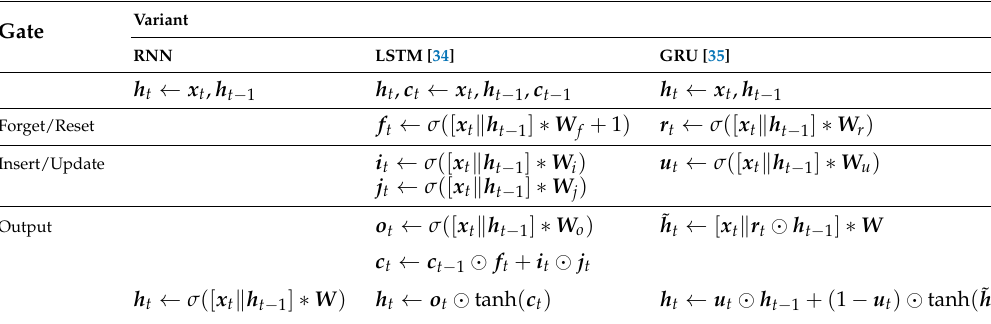
Figure 1. Schematic illustration of long short-term memory (LSTM) and gated recurrent unit (GRU) cells analogous to the cell definitions in Table 1. The cell output h t is calculated via internal gates and, based on the current input x t , combined with prior context information h t 1 , c t 1 . This is realized by a concatenation (concat.) of these tensors, as illustrated by merging arrows. LSTM cells are designed to separately accommodate long-term context in the internal cell state c t 1 , from short-term context h t 1 . GRU cells combine all context information in a single, but more sophisticated output h t 1 . Table 1. Update formulas of the convolutional variants of standard recurrent neural networks (RNNs), long short-term memory (LSTM) cells and gated recurrent units (GRUs). A convolution between matrices a and b is denoted by a b ; element-wise multiplication by the Hadamard operator a b ; ∗ (cid:12) and concatenation on the last dimension is marked by [ a b ] . The activation functions sigmoid σ ( x ) (cid:107) and tangens hyperbolicustanh ( x ) are used for non-linear